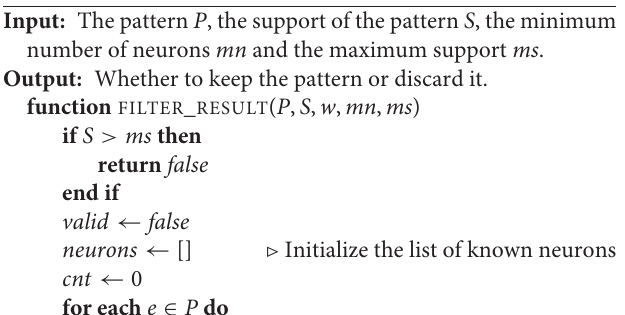
Algorithm 1: Filter function used by